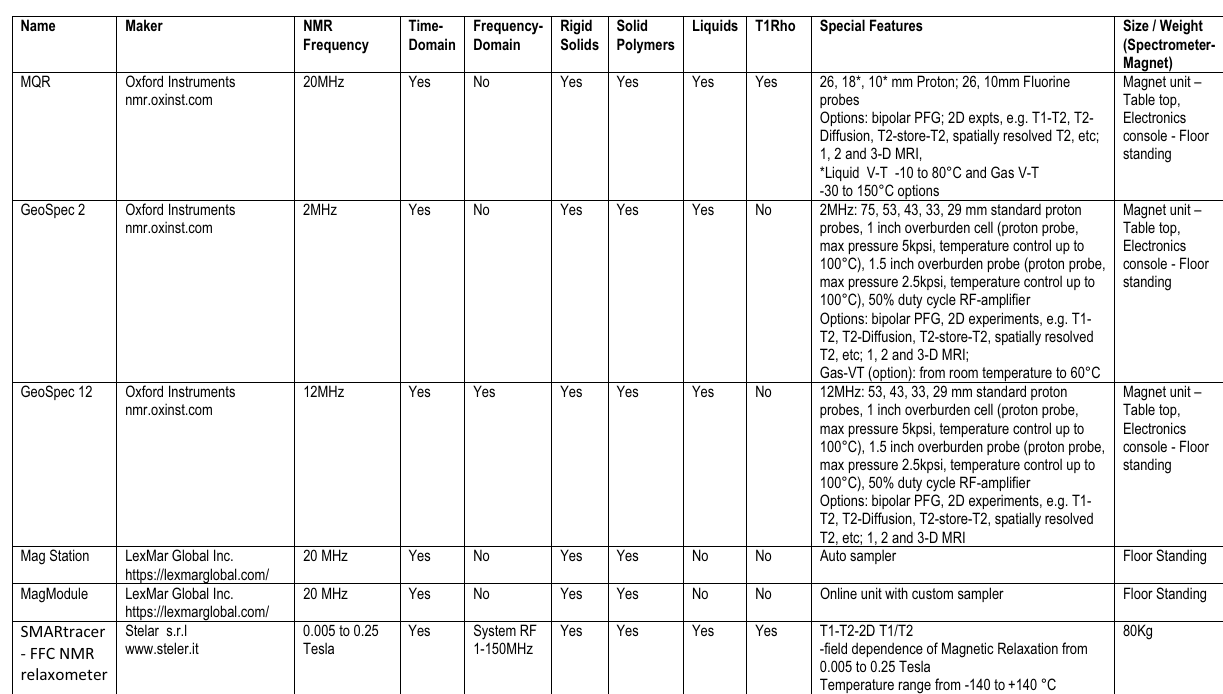
Fig. 6 Larger/floor-standing time-domain NMR spectrometers